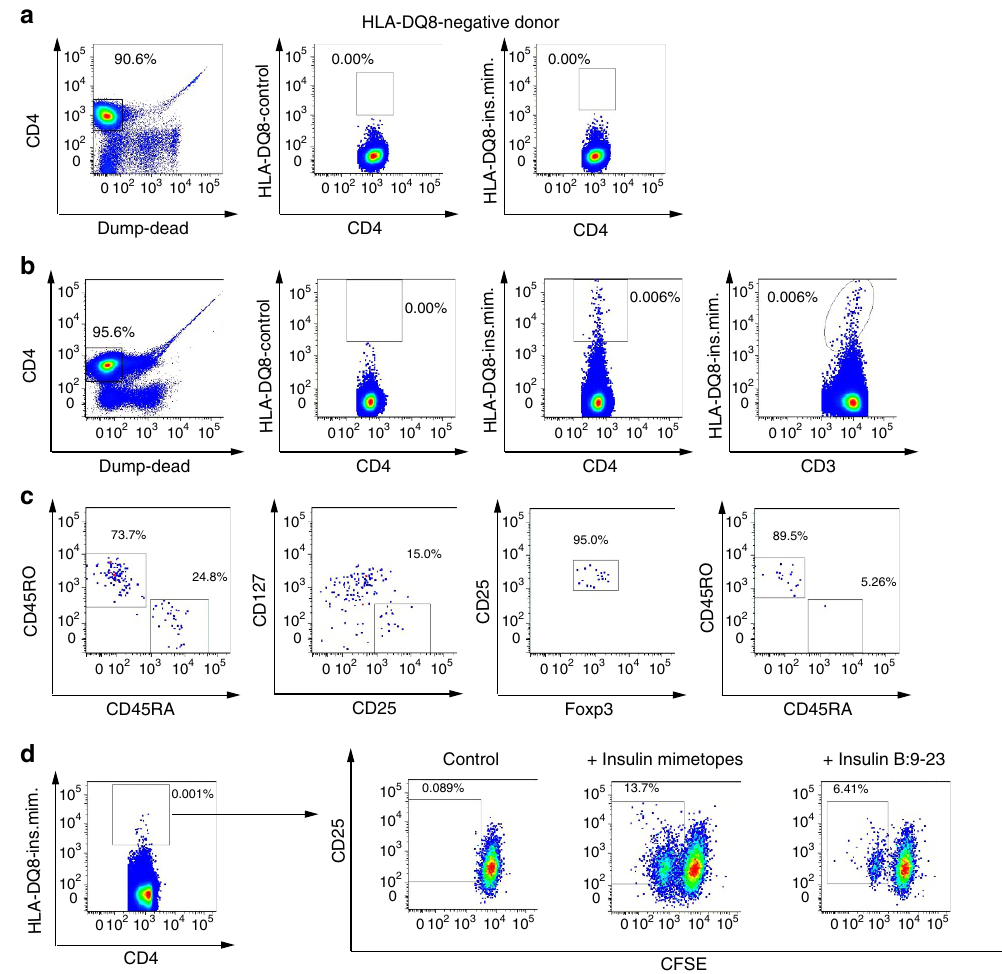
Figure 2 | Ex vivo identification of human HLA-DQ8-restricted insulin-specific regulatory T cells. Human CD4 þ T cells were analysed by FACS, first gating on live, CD14 (cid:3) , CD19 (cid:3) , CD8a (cid:3) , CD11b (cid:3) , CD4 þ (left; a , b ) and CD3 þ , followed by examination of tetramer binding. ( a ) Representative FACS plots for the direct ex vivo identification of HLA-DQ8-restricted insulin-specific CD4 þ Tcells. Control staining was performed to assess the quality and specificity of the tetramer staining using a combination of two control tetramers fused to irrelevant peptides (centre) or using CD4 þ T cells from an HLA-DQ8 - negative individual (right). ( b ) Representative FACS plots for the quality of HLA-DQ 8-restricted insulin-specific tetramer staining gating against CD4 (centre) and CD3 (right). ( c ) Representative FACS plots for the phenotypic characterization of HLA-DQ8-restricted insulin-specific CD4 þ Tcells based on CD45RA versus CD45RO expression (memory status) and of insulin-specific Foxp3 þ Tregs based on CD127 low CD25 high and Foxp3 high expression. ( d ) Re-stimulation of sorted and purified tetramer þ CD4 þ Tcells (example plot on the left) either left untreated ( ¼ control, left) or stimulated with insulin mimetopes (ins.mim.1,2,3,4 at final 10ngml (cid:3) 1 , middle plot), or with insulin B:9-23 (100ngml (cid:3) 1 , right), as assessed by analysing the dilution of the CFSE label and CD25 expression.